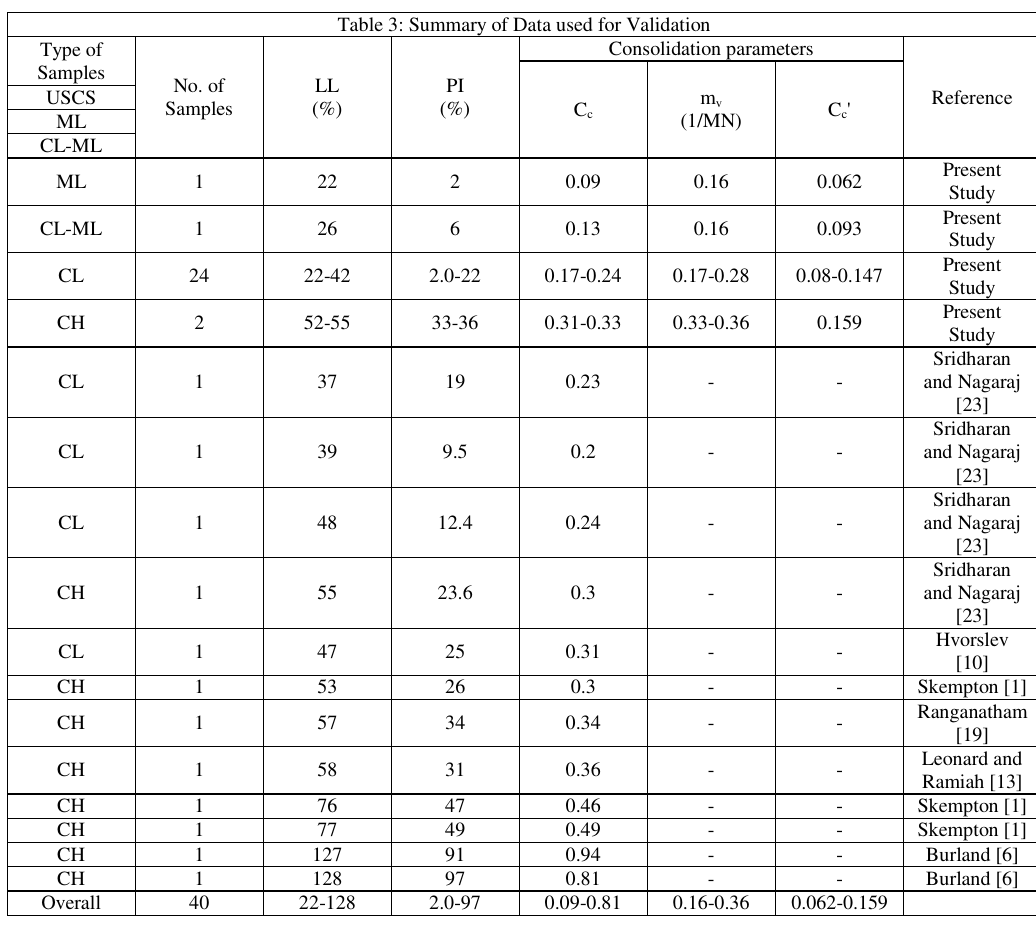
Table 3: Summary of Data used for Validation